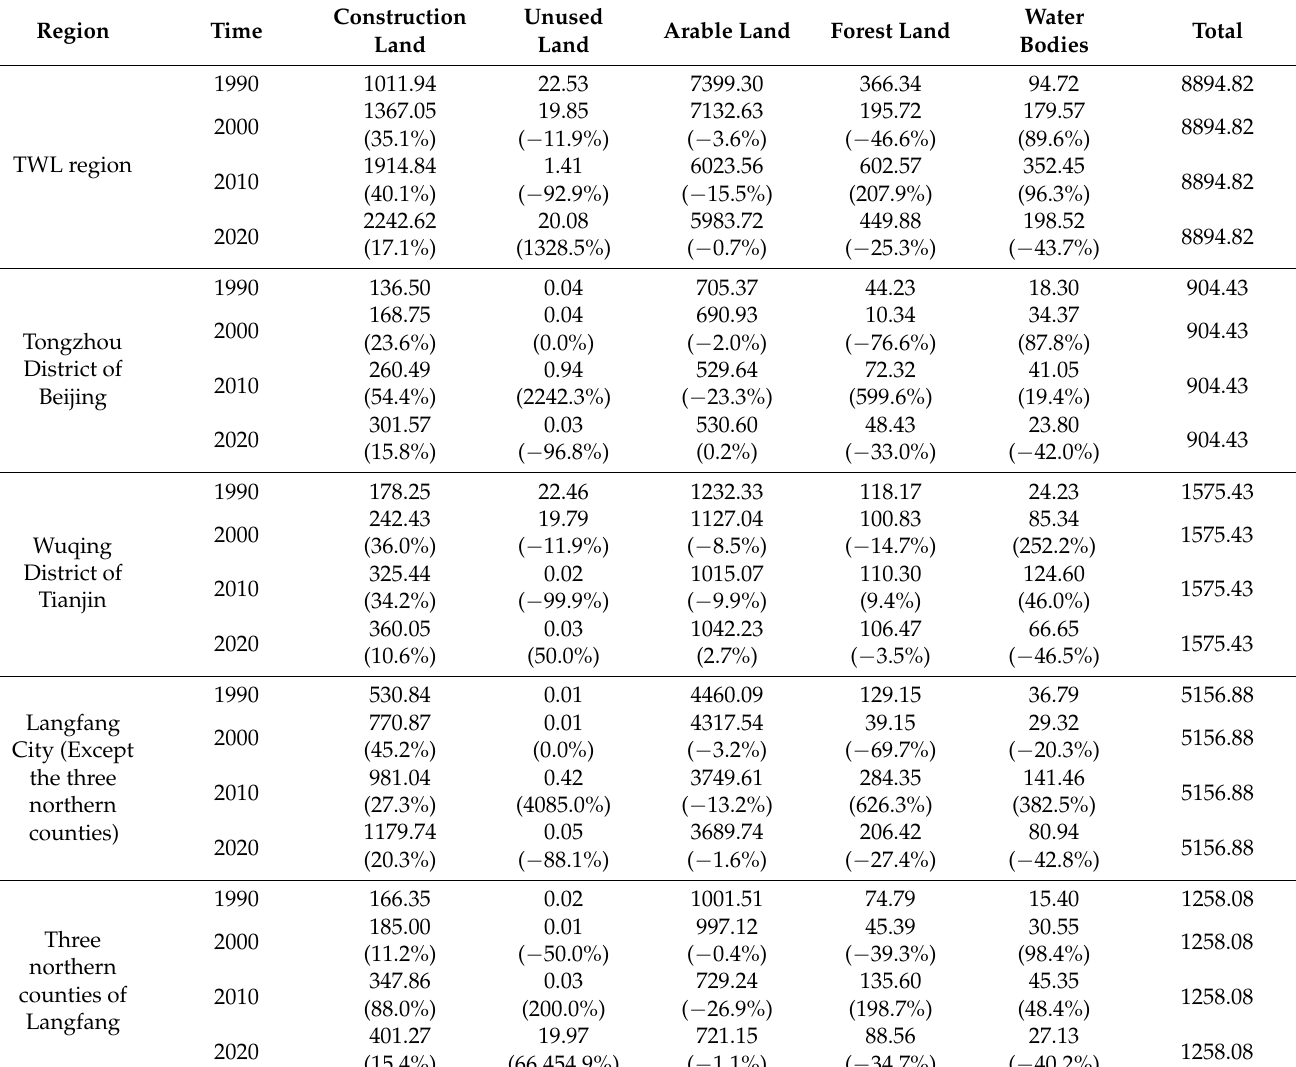
Table 2. Land use structure of the TWL region from 1990–2020 (km 2 ) and percentage change in each decade